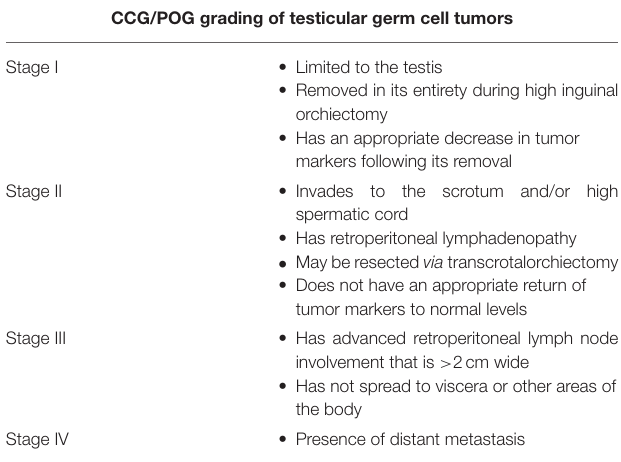
TABLE 1 | Children’s Cancer Group/Pediatric Oncology Group (CCG/POG) staging system [modified from Schlatter et al. (